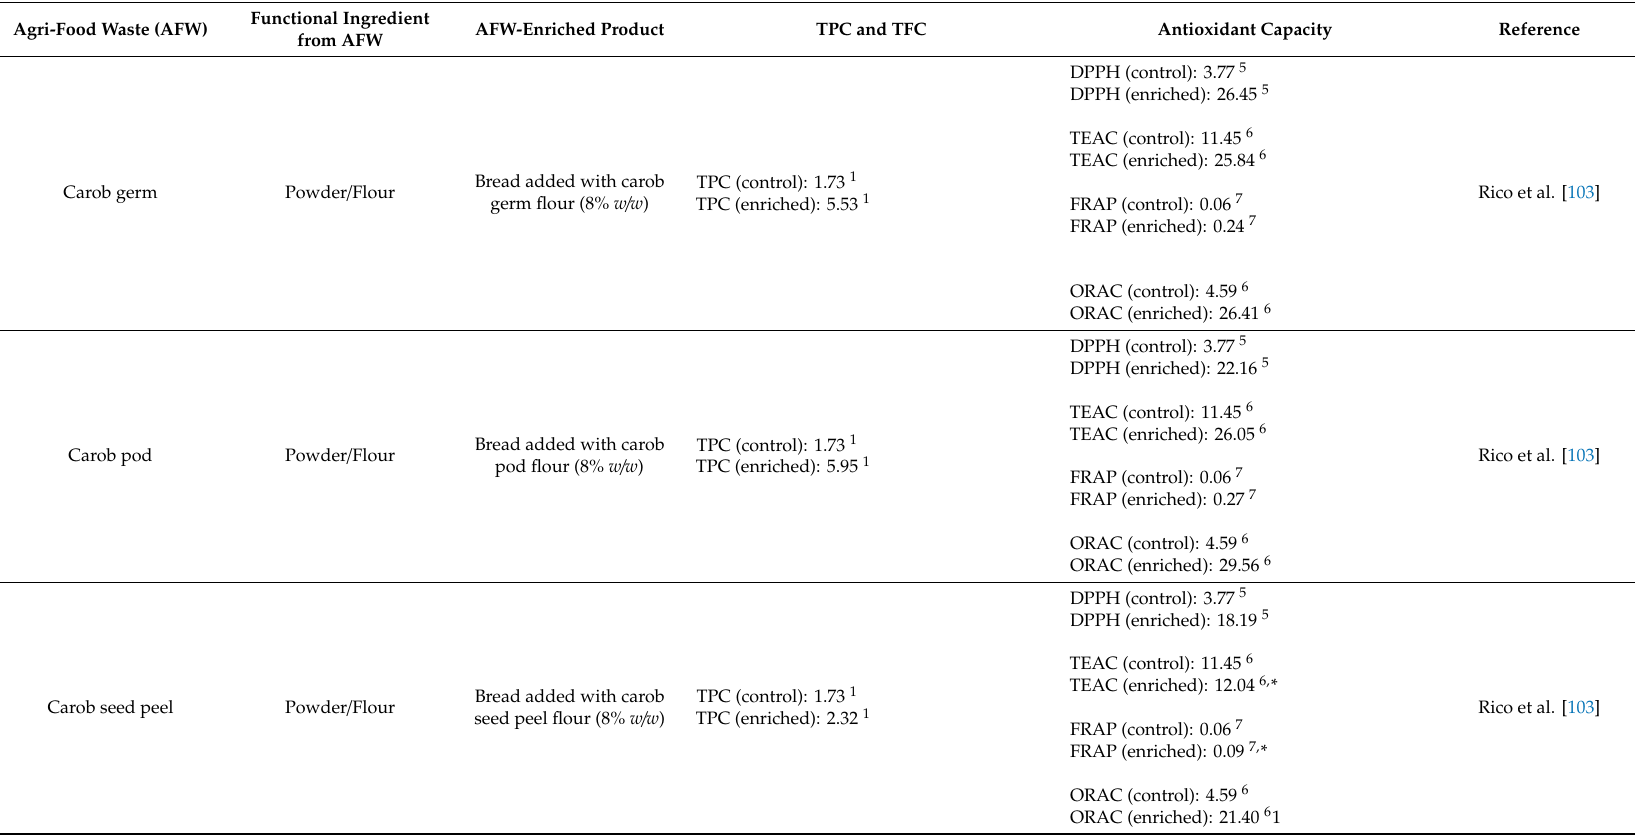
Table 2. TPC and antioxidant capacity of bakery products formulated by the addition of waste from seed and oilseed